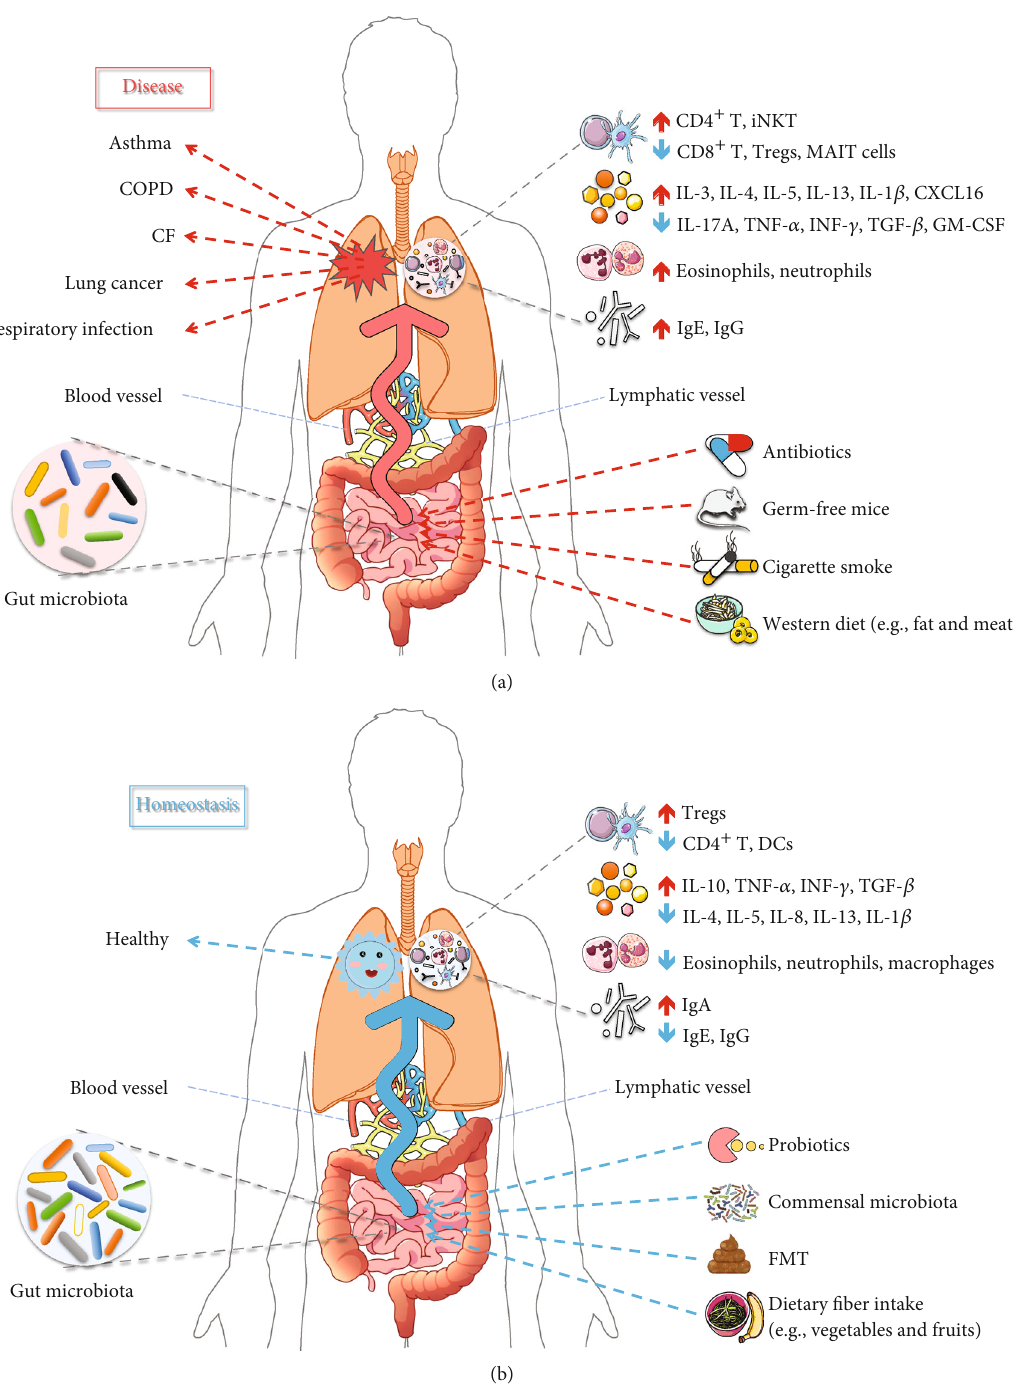
Figure 1: The role of gut microbiota in respiratory disease and homeostasis. The dysbiosis of gut microbiota contributes to respiratory diseases (a), while a healthy gut microbiota plays a protective role in the lung (b). The gut microbiota is in fl uenced by several factors, including antibiotics, probiotics, cigarette smoke, diets, and fecal microbiota transplantation (FMT), and is associated with lung health and disease by regulating the respiratory immunity and in fl ammation through the blood and lymphatic system. ↑ : increase; ↓ :